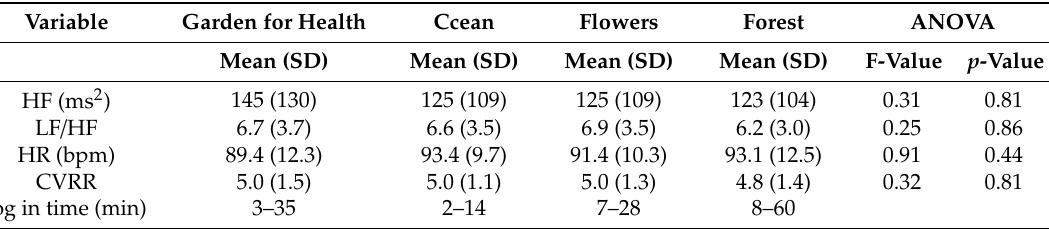
Table 4. Mean HRV by environmental area.